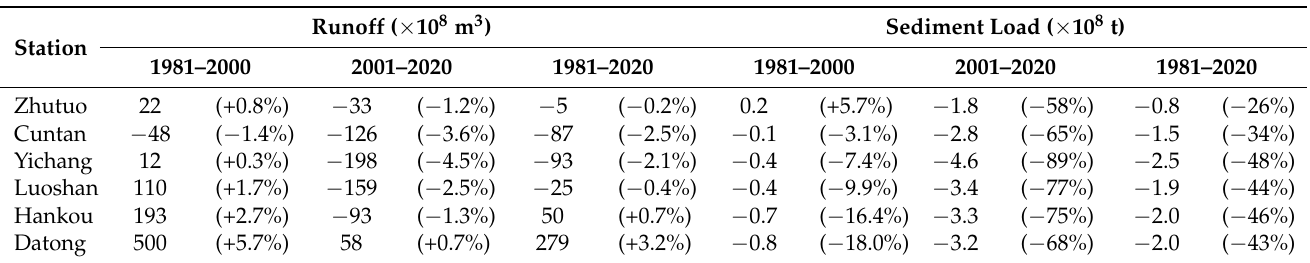
Table 3. Variations in runoff and sediment load for different periods, compared to the natural period (1961–1980) *.